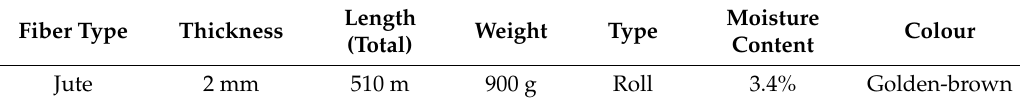
Figure 1. Appearance and microstructure images of jute fibers, obtained using SEM. Figure 2. The physical appearance of the jute fibers used in this study, which were cut into different length.